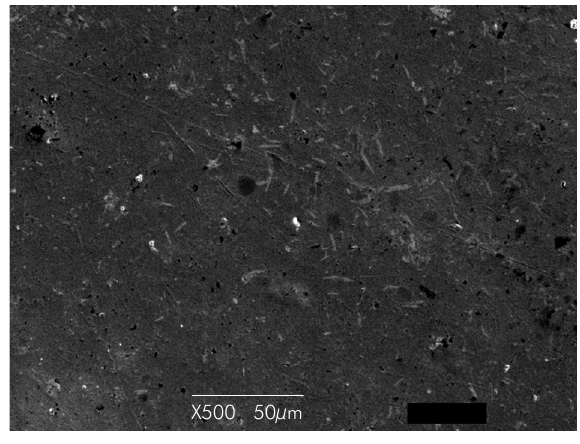
Figure 2. Frontal photomicrograph (specific) at 500x